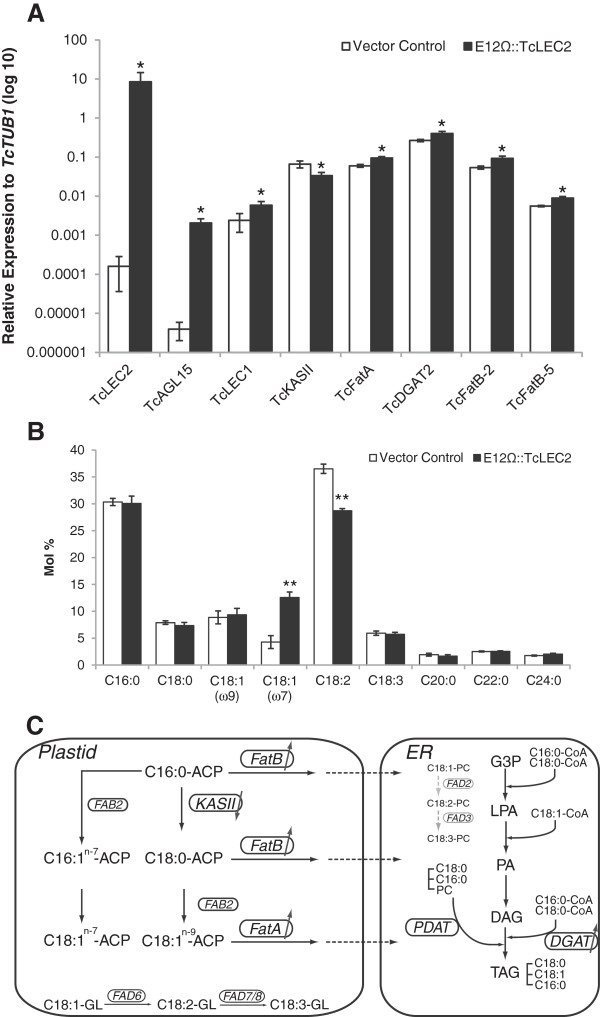
Transient overexpression of E12Ω::TcLEC2 in IZE altered fatty acid compositions and gene expression. A. Changes of the expression levels of responsive enzymes on the fatty acid biosynthesis pathway; expression levels of genes were normalized relative to that of TcTUB1; (n = 3, mean ± SE) *represents for p-value < 0.05 by t-test. B. Molar percentages of fatty acid compositions in cacao immature zygotic embryos transiently overexpressing vector control and E12Ω::TcLEC2, respectively; (n = 3, mean ± SE). **represents for p-value < 0.001 by t-test. C. Diagram of proposed model to explain the relationship between gene expression levels and altered fatty acid compositions. Enzymes are marked in circle. Enzymes that were regulated by the activity of TcLEC2 are in black, otherwise, in grey. Abbreviation: ER, endoplasmic reticulum; ACP, acyl carrier protein; CoA, Coenzyme A; FAB2, fatty acid desaturase; Fat, fatty acyl-ACP thioesterase; KAS, 3-ketoacyl-ACP synthase; FAD2, oleoyl desaturase; FAD3, linoleoyl desaturase; FAD6, oleoyl desaturase on membrane glycerolipid; FAD7/8, linoleoyl desaturase on membrane glycerolipids; PC, phosphatidylcholine; G3P, glycerol-3-phosphate; LPA, lysophosphatidate; PA, phosphatidate; DAG, diacylglycerol; TAG, triacylglycerol; PDAT, phospholipid:diacylglycerol acyltransferase; DGAT, 1,2-sn-diacylglcyerol transferase.